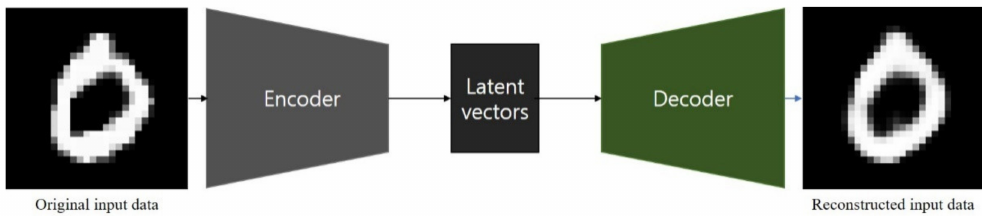
Figure 4. Working process of an autoencoder: transforming input data to compressed latent vectors and then decoding it as the